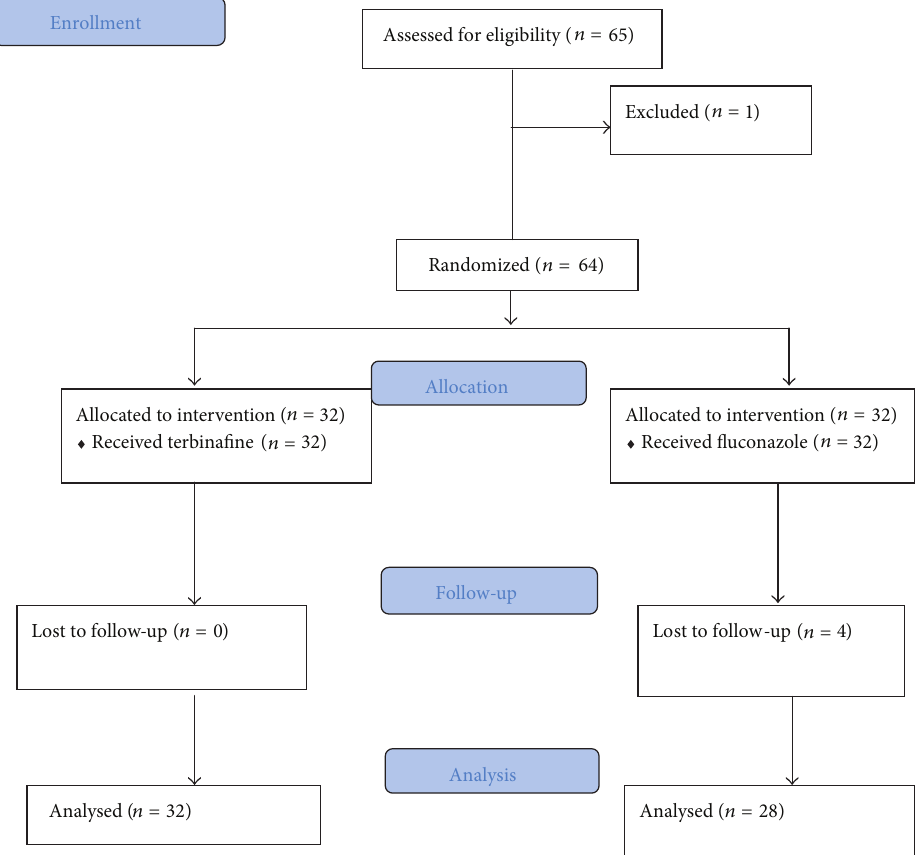
Figure 2: CONSORT 2010 flow